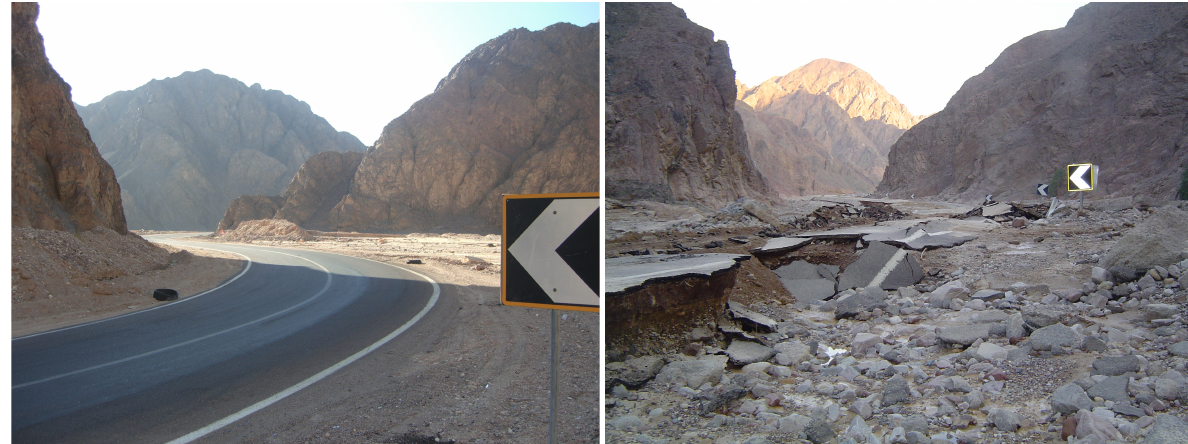
Fig. 4. International road running through the canyon, close to the outlet Wadi Watir. Left: normal state in dry conditions; Right: damage resulting from the flash flood of 24 October